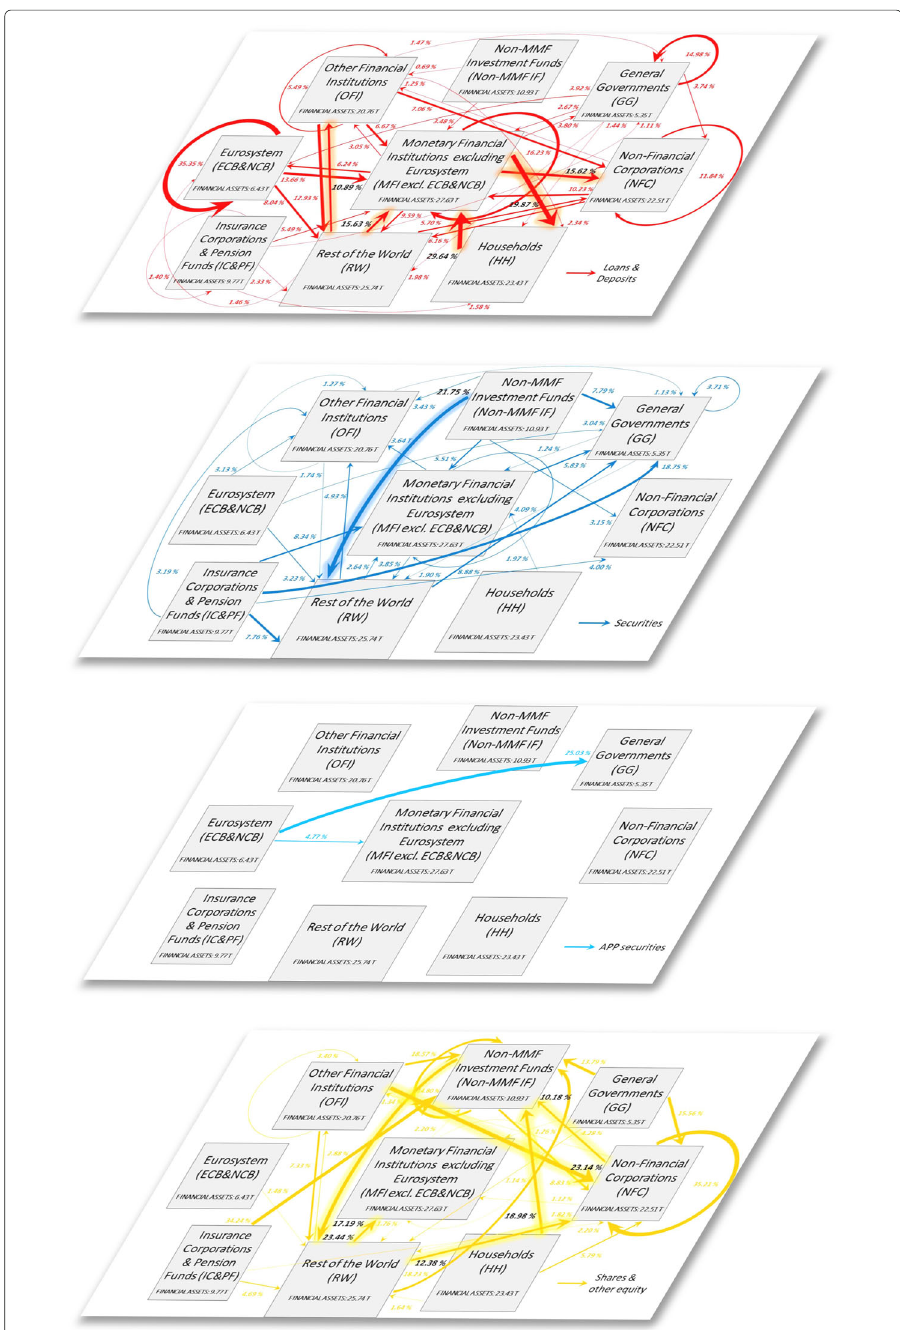
Fig. 9 The multilayer macro-network of financial exposures in the euro area; June 2017. Multilayer macro-network of financial exposures among the different institutional sectors operating in the euro area (i.e., Eurosystem (ECB&NCB), Monetary Financial Institutions excluding the Eurosystem (MFI excl. ECB&NCB), Other Financial Institutions (OFI), Non-MMF Investment Funds (Non-MMF IF), Insurance Corporations and Pension Funds (IC&PF), Households (HH), Non-Financial Corporations (NFC), General Governments (GG)), and the Rest of the World (RW), via i) loans and deposits (first layer, red links), ii) private and public debt securities (second layer, blue links), iii) APP securities (third layer, light blue links), and iv) shares and other equity (fourth layer, yellow links), with reference to the second quarter of 2017. Weights represent the outstanding financial exposures of a source institutional sector to a target institutional sector and they are normalized by total assets of the source. Data sources: (European Central Bank 2017b) and (European Central Bank